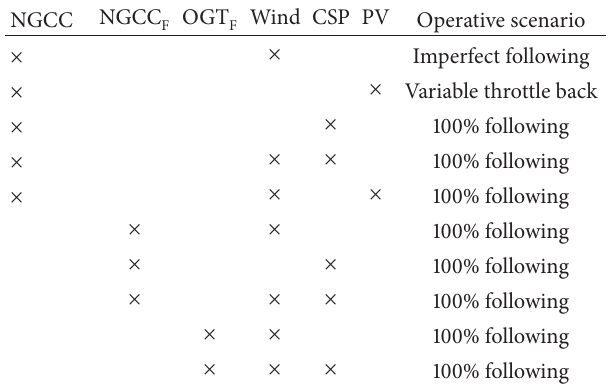
Table 7: Best combinations of energy sources (case study). NGCC